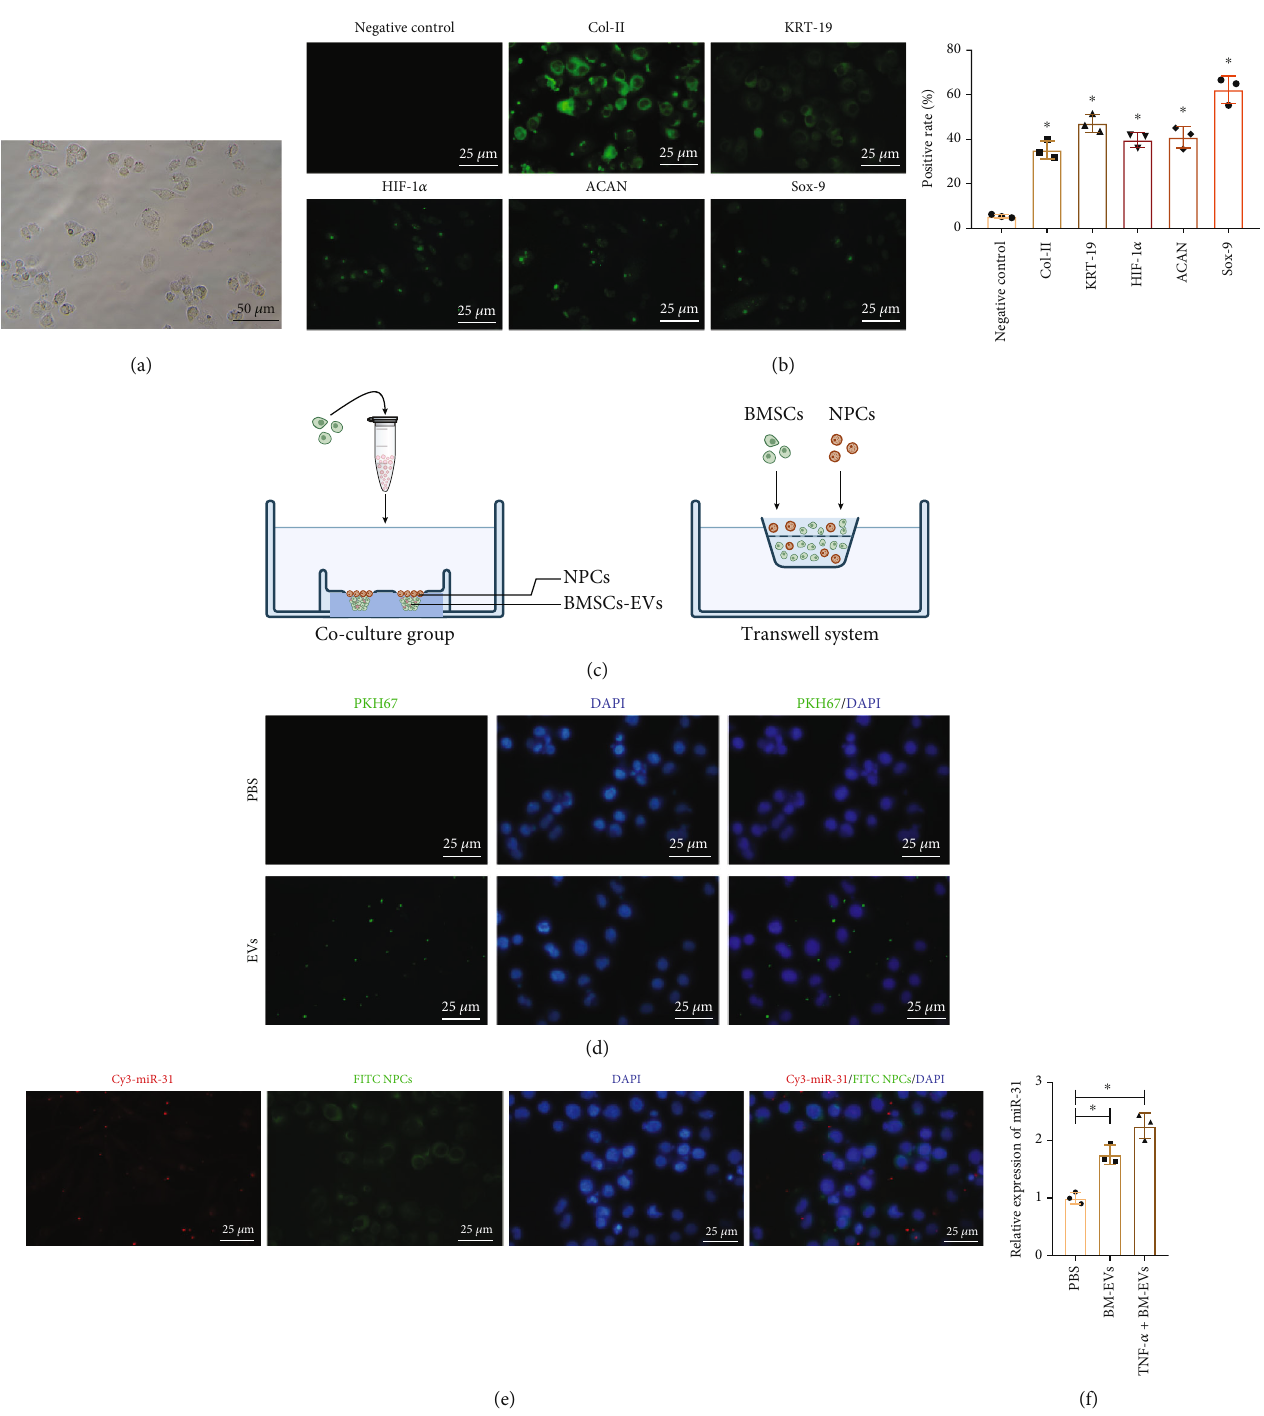
Figure 3: hBMSC-EVs deliver miR-31 to NPCs: (a) microscopic images of NPCs. Scale bar = 50 μ m. (b) Immuno fl uorescence detection of Col II, KRT-19, HIF-1 α , SOX-9, and ACAN proteins in the NPCs. Scale bar = 25 μ m. (c) Diagram showing coculture of hBMSCs or hBMSC-EVs with NPCs. (d) Confocal microscopy was used to observe the uptake of PKH-67 labeled EVs by NPCs after coculture for 24h. Scale bar = 25 μ m. (e) Representative fl uorescence micrographs in NPCs cocultured with Cy3-miR-31-BMSCs (red). Scale bar = 25 μ m. (f) miR-31 expression in NPCs cocultured with BMSC-EVs or TNF- α +BMSC-EVs determined by RT-qPCR. ∗ p < 0 : 05 . Cell experiments were repeated three